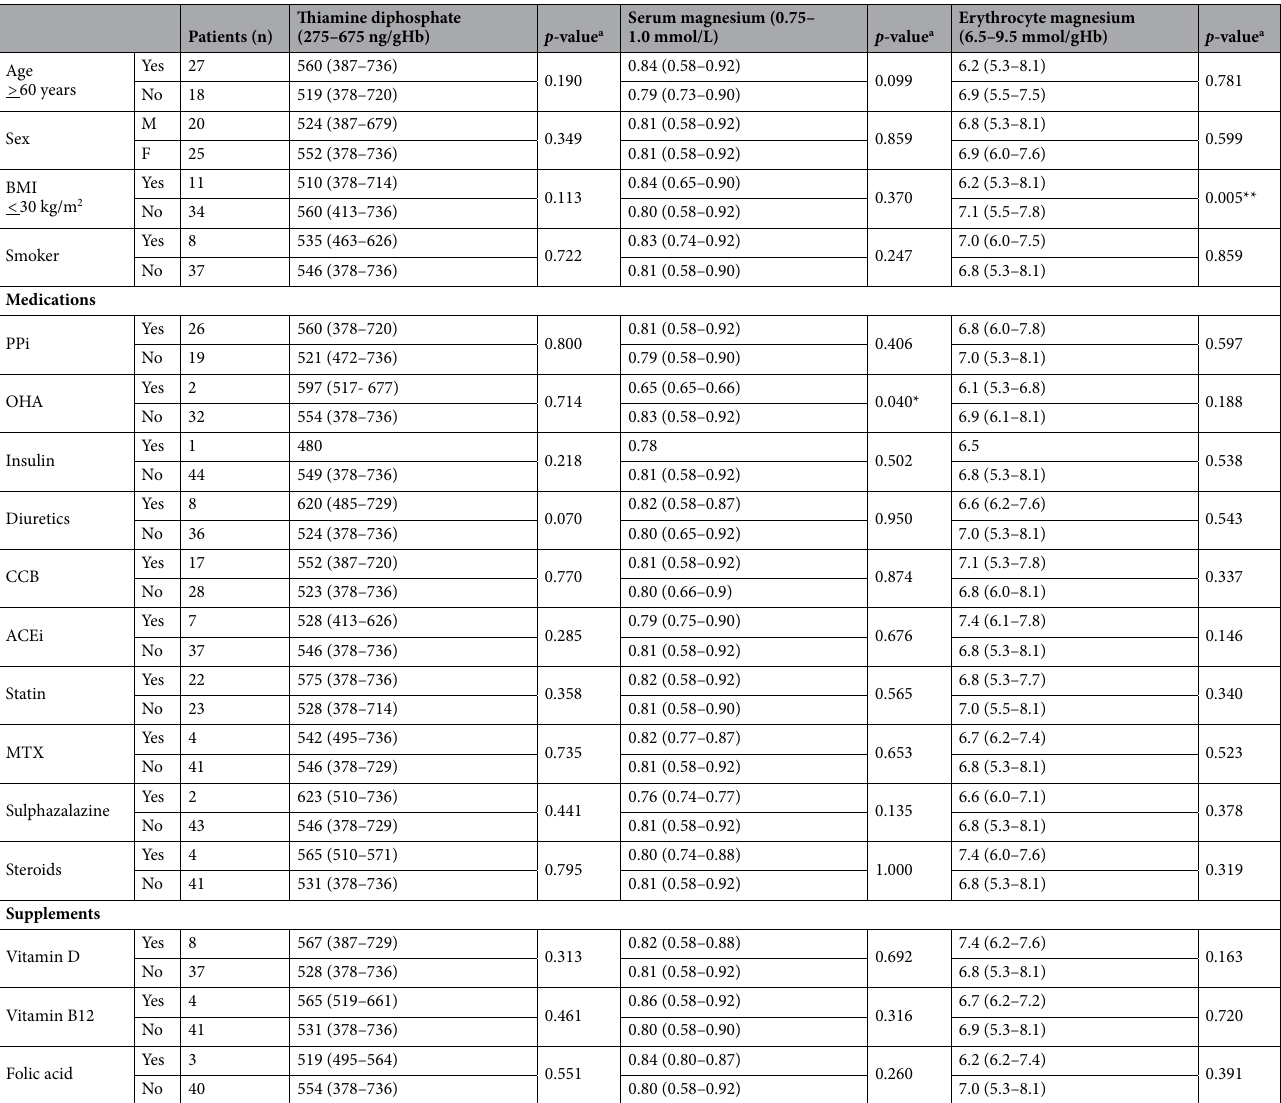
Table 1. The relationship between baseline thiamine and magnesium concentrations and clinicopathological characteristics of patients who underwent elective surgery for knee arthroplasty (n = 45). PPi’s proton pump inhibitors, OHA’s oral hypoglycaemic agents, CCB calcium channel blocker, ACEi angiotensin converting enzyme inhibitor, MTX methotrexate, BMI body masss index. Values are medians; IQR in